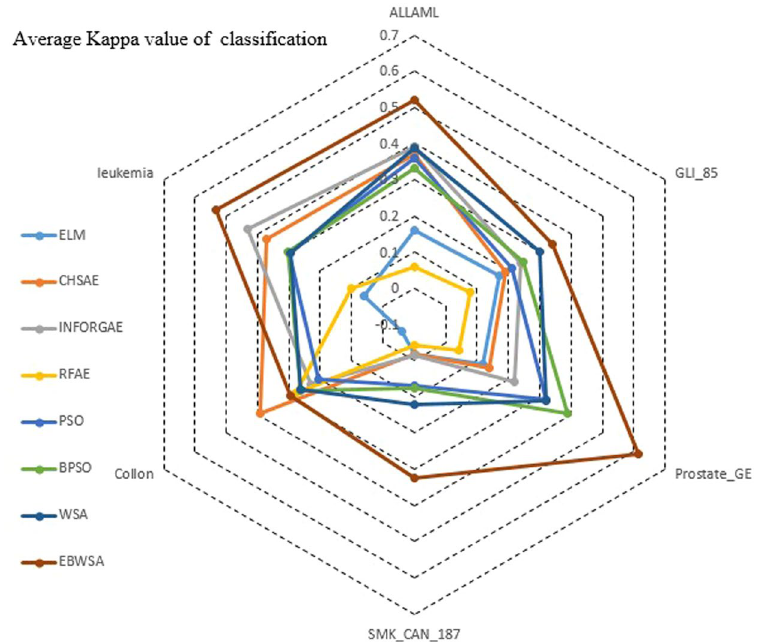
Figure 2. Average Kappa value of classification of all